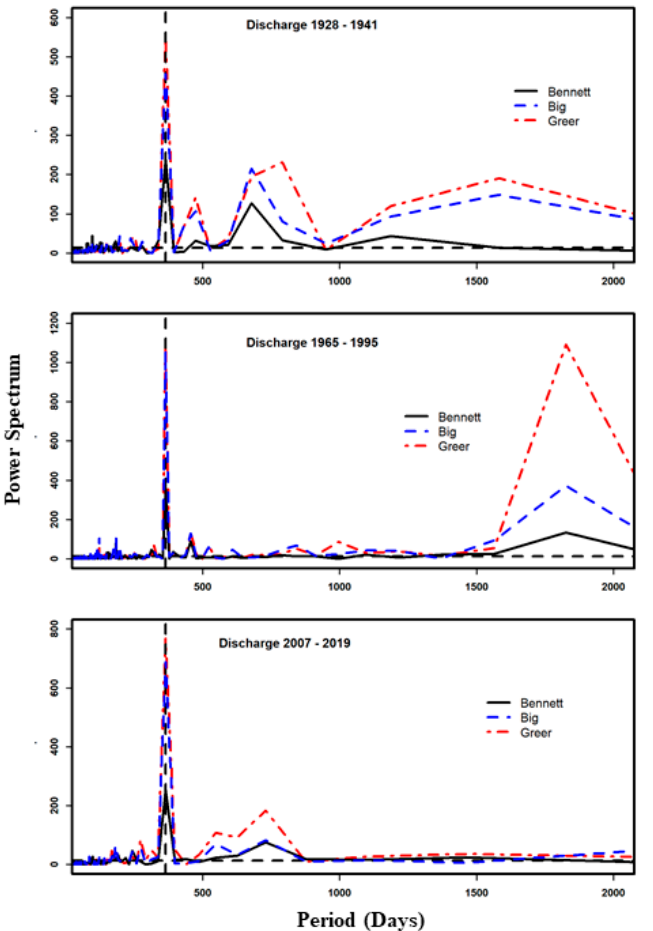
Figure 7. Lomb–Scargle periodograms for the studied springs for 1928–1941, 1965–1995, and 2007–2019. The horizontal dashed line represents the power spectrum (=15) above which the slope breaks (i.e., periodicities) are significant.